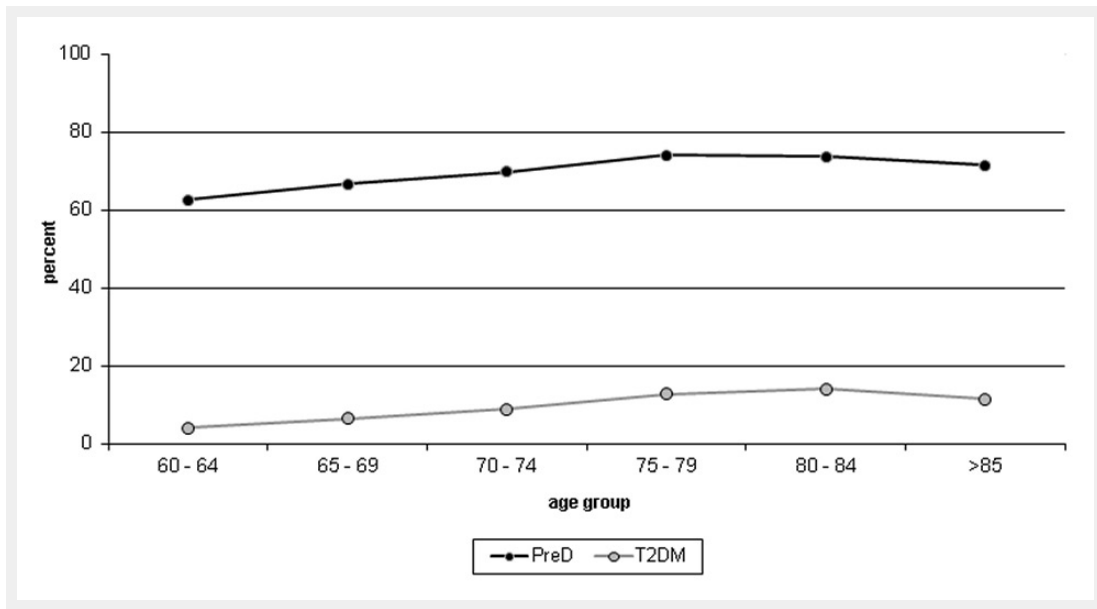
Figure 2 Prevalence of unknown prediabetes (PreD) and type 2 diabetes mellitus (T2DM) by age group. The prevalence of impaired fasting glucose (suppositious PreD) and T2DM continued to increase with age older than 60 years, and there is a curve exhibiting saturation characteristics from age 80 years